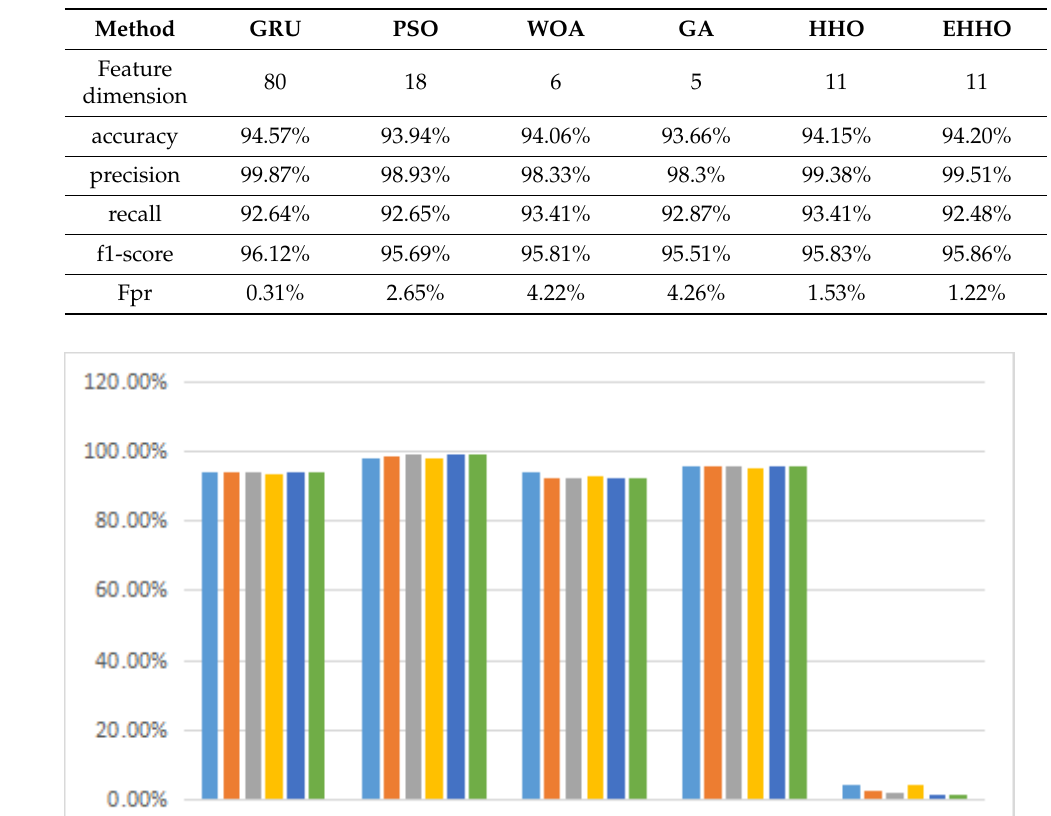
Table 11. The results of the CICIDS2018 binary classification experiment.